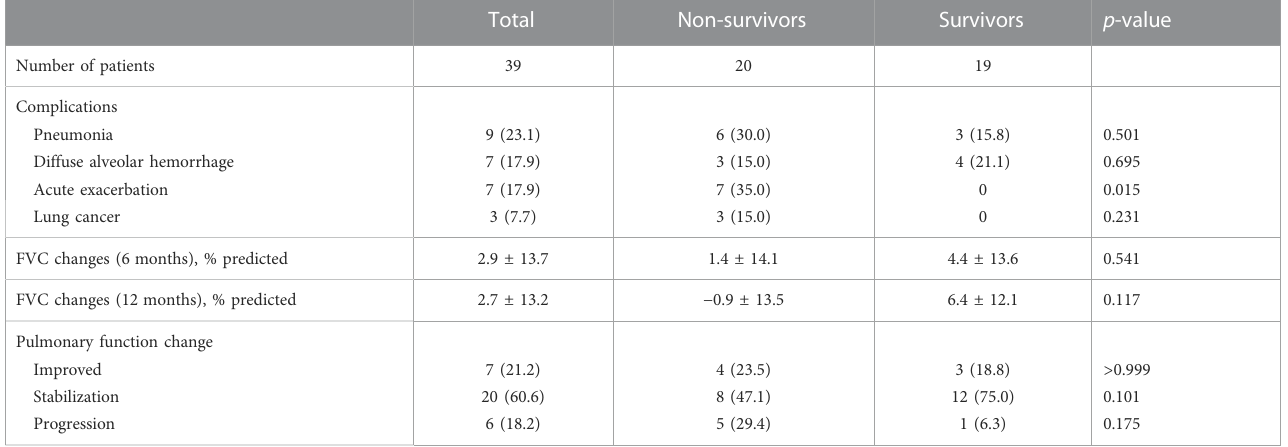
TABLE 2 Comparison of the clinical course between the non-survivors and survivors among patients with